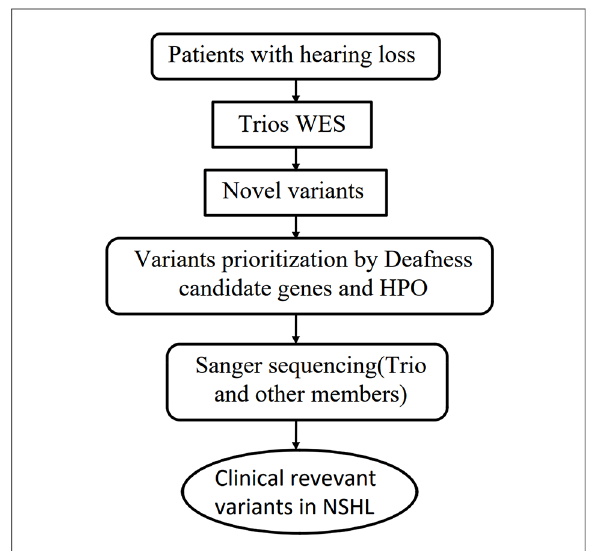
FIGURE 1 Flowchart to detect rare variants relevant to NSHL by WES.